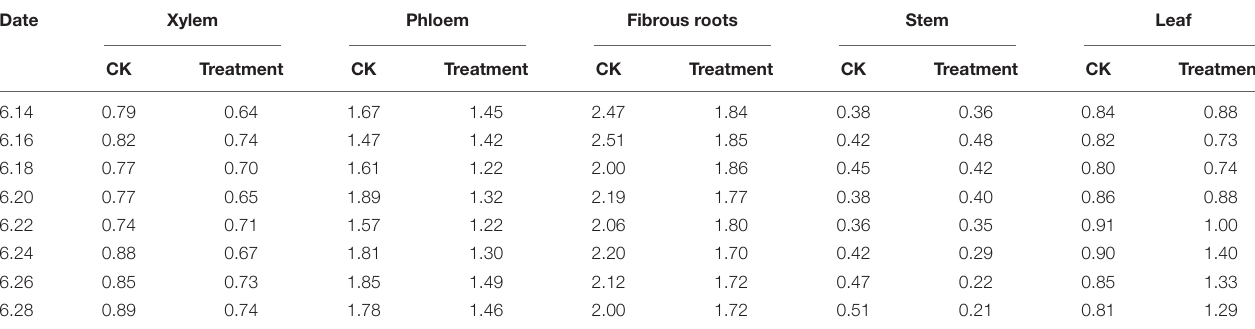
FIGURE 8 | Effects of cold stress on the PPT ginsenoside content in different tissues of flowering ginseng. The X axis represents the sampling time. * p < 0.05 and ** p < 0.01, compared with control group. The data are expressed as the mean ± SD ( n = 3). TABLE 3 | PPD/PPT ginsenoside content ratios in different ginseng tissues under cold stress during the flowering